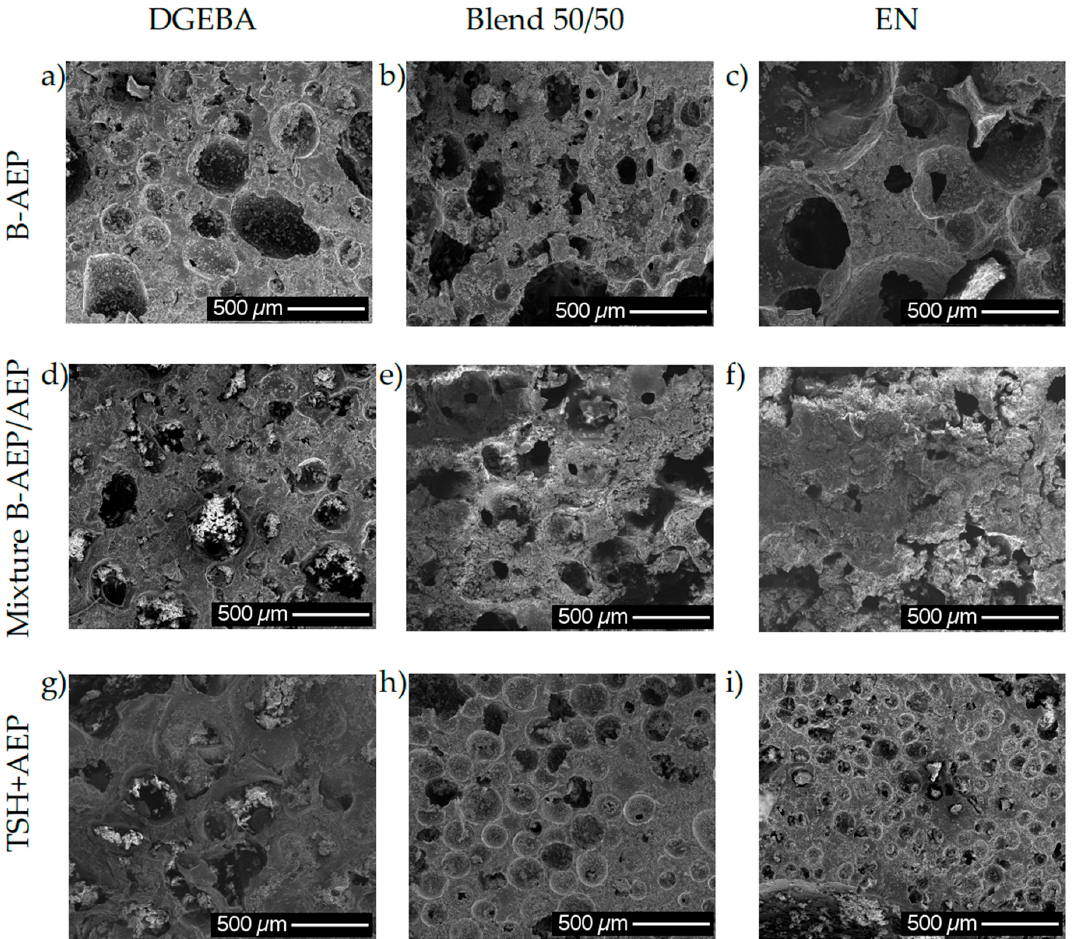
Figure 7. SEM images of central regions of foams obtained by different formulations.The foams obtained by the use of B-AEP only with DGEBA ( a ), blend 50/50 ( b ) and EN ( c ) do not contain any unblocked AEP. The B-AEP/AEP mixtures were 80/20 of the stoichiometric amount required for the curing at DGEBA ( d ) and the blend 50/50 system ( e ); and 85/15 at EN ( f ). The systems containing TSH as blowing agent with DGEBA (g), blend 50/50 (h) and EN (i) contain 100% stoichiometric ublocked AEP.